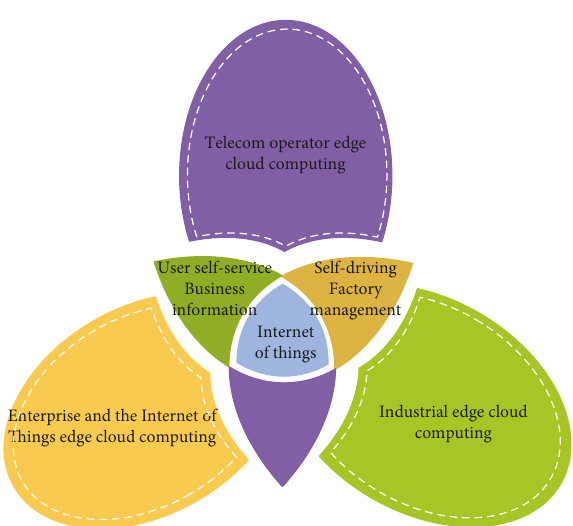
Figure 3: Schematic diagram of edge cloud computing classifi- cation and interrelationship.